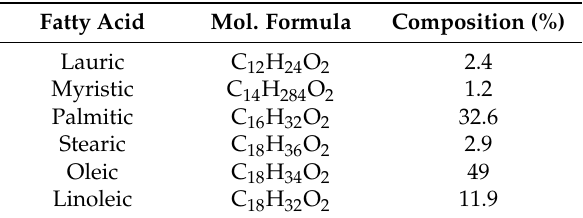
Table 4. Fatty acid composition of